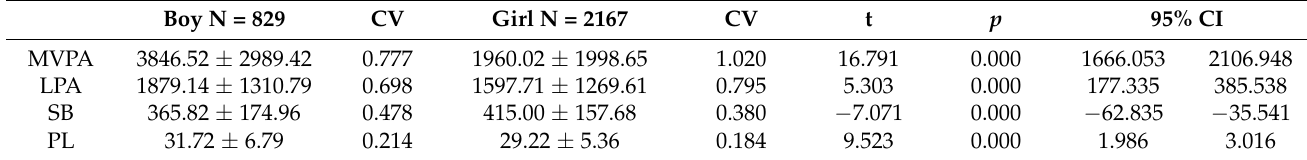
Table 2. Comparison of the results of MVPA, LPA, SB and PL by gender.